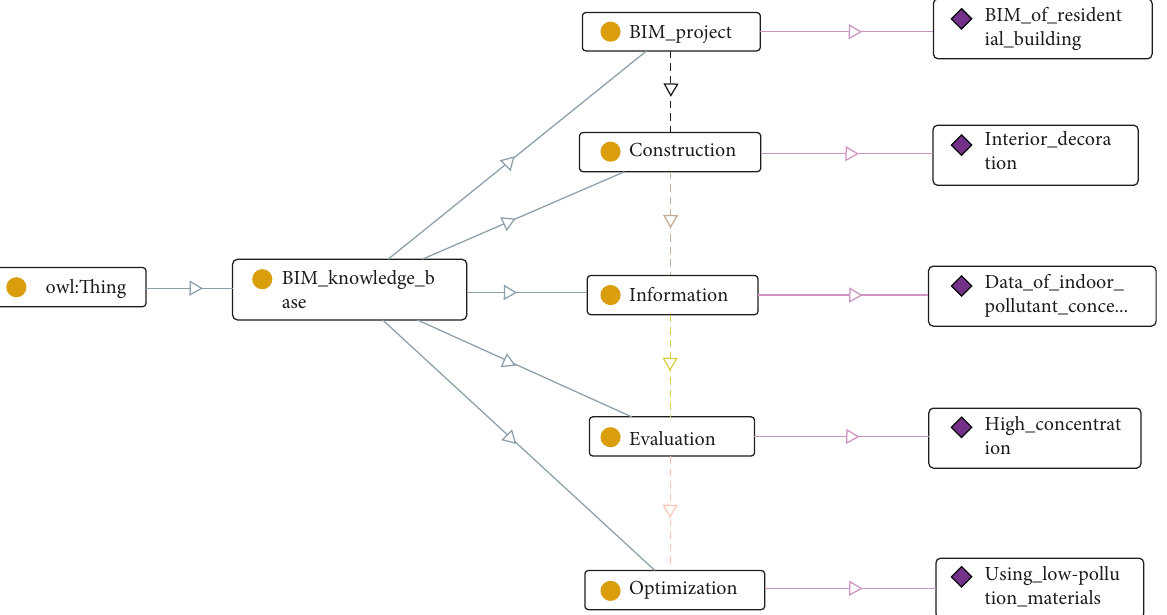
Figure 9: Link relationship of BIM knowledge The rules above can be represented directly by Figure 10. The solid lines stand for the known re- lationships, while dotted lines stand for the implicit relationships inferred by SWRL rules.